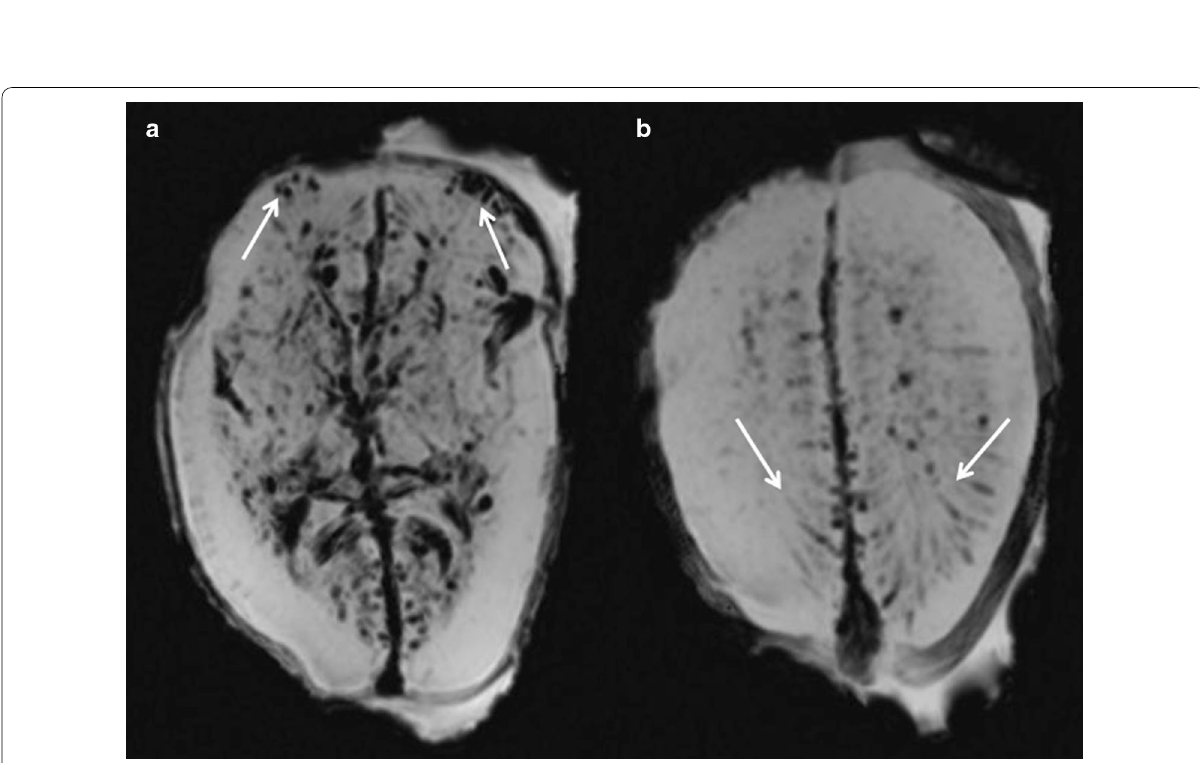
Fig. 5 25‑week foetus with normal cerebral lamination. Axial SWI images. a Appearance of the post‑mortem brain with clots in cortical veins (arrows), b clots in intramedullary veins